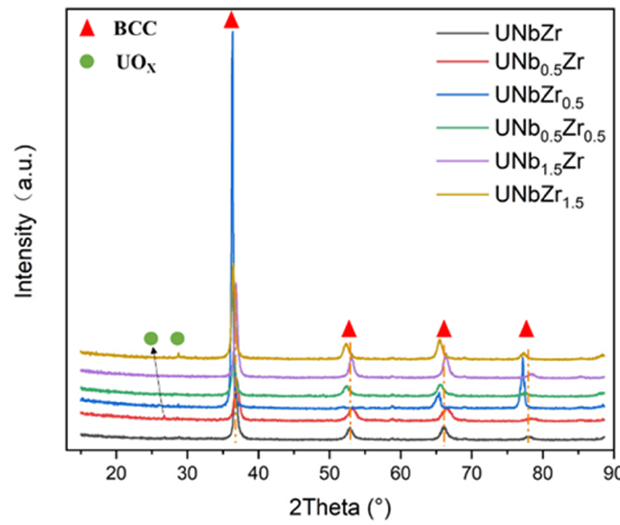
Figure 3. XRD diffraction patterns of the medium entropy alloy in U-Nb-Zr.